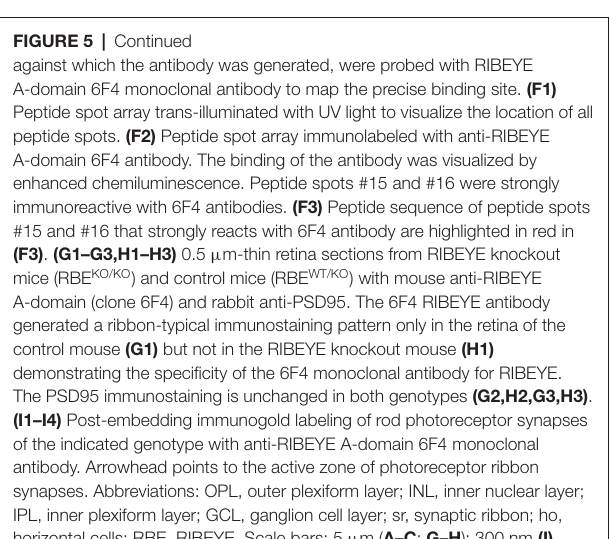
(I1–I4) Post-embedding immunogold labeling of rod photoreceptor synapses of the indicated genotype with anti-RIBEYE A-domain 6F4